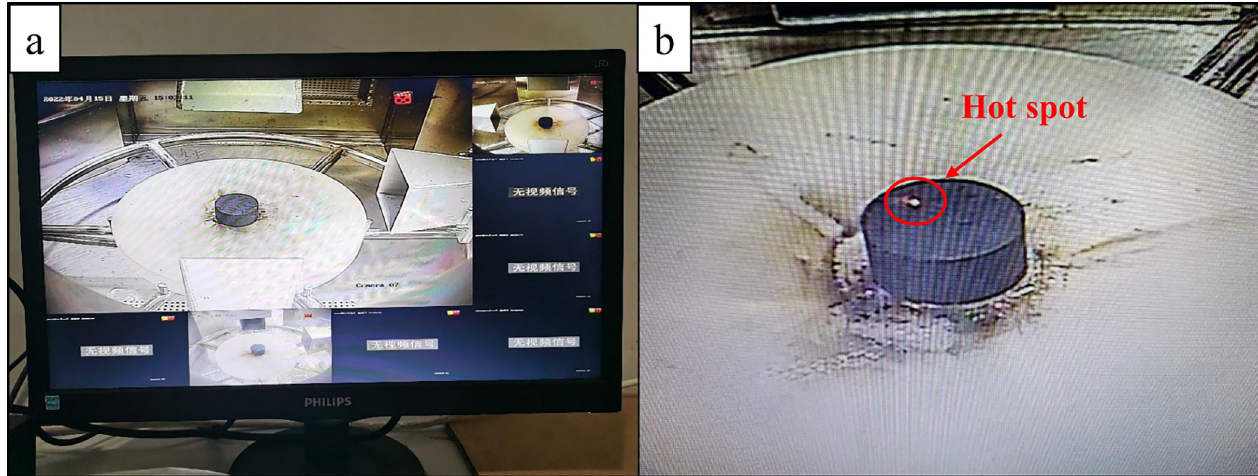
Fig 2. Multiple-angle video surveillance and hot spot